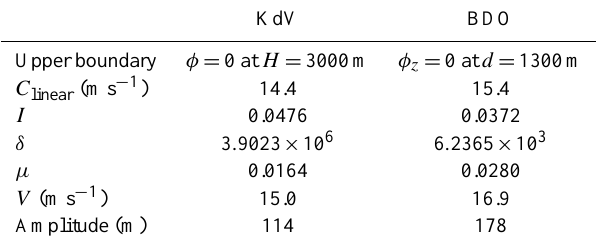
Table 1. List of values obtained by weakly nonlinear long wave analysis for the case study presented in Sect. 2, according to ex- pressions (3, 4, 5 and 6). C linear refers to the linear long wave phase speed solving Eq. (1) with the boundary condition indicated in the first line of the table. 8 refers to the modal function and the subscript indicates differentiation with respect to the vertical coor- dinate. See text for details.